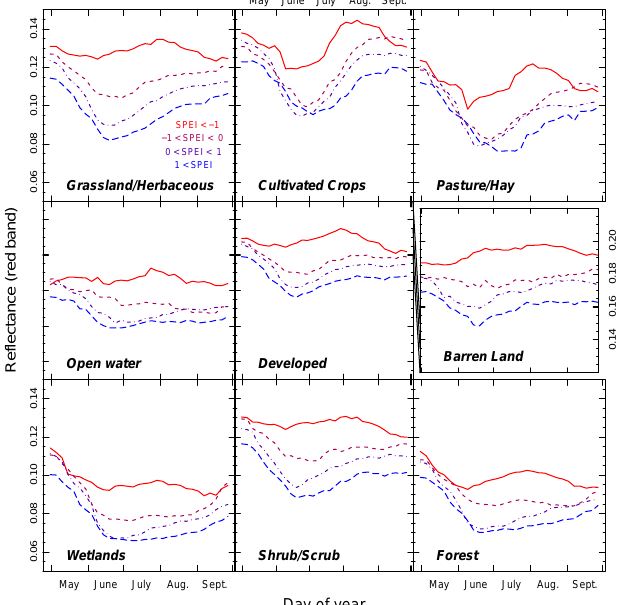
Figure 7. Average red reflectance by day of year, drought intensity, and LULC. Each point on the lines shows the average red reflectance for all pixels in the study area/period that are within a 40 day window of the day of year, the specified SPEI range, and the specified LULC category. The solid red line is the driest category (SPEI < − 1); the short dashed maroon line is drier than average (SPEI between − 1 and zero); the dashed dotted indigo line is wetter than average (SPEI between zero and one); and the dashed blue line the wettest (SPEI > 1). Note the different scale for the barren category. The observation count in each point of this plot is available in Figure A4.